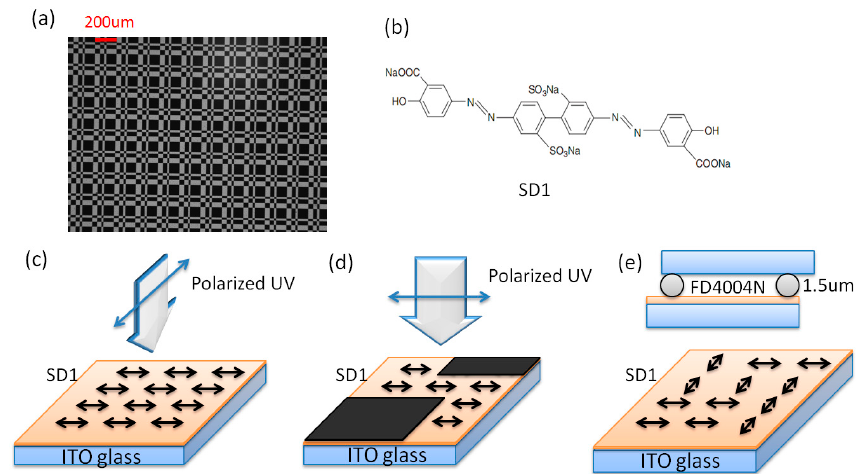
Figure 4. Experiment detail for the FLC DG ( a ) Microscopic photo of chrome mask; ( b ) Chemical structure of SD1; ( c ) The first exposure of polarized UV on the SD1 substrate; ( d ) Exposure of SD1 substrate with chrome mask; ( e ) Demonstration of the FLC DG structure and the alignment structure after the two-step exposure.